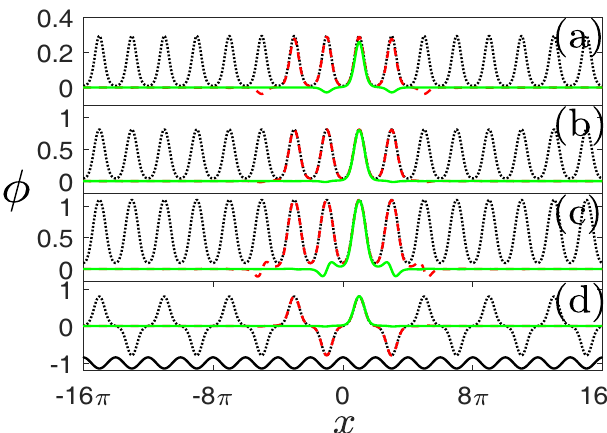
Figure 4. Nonlinear Bloch waves originating from the center ( a – c ) and edge ( d ) of the BZ and FGSs in the first band gap. Dotted (black), solid (green), and dashed (red) lines stand for NLBWs, FGS, and truncated-Bloch-wave solitons, respectively. ( a ) N = 0.1317, b = − 0.88; ( b ) N = 1.2418, b = − 0.45; ( c ) N = 2.6653, b = 0; ( d ) N = 1.1506, b = − 0.45. The solid curve at the bottom of ( d ) denotes the distribution of a lattice. α = 1.6 and p = 1.5 in all the panels.